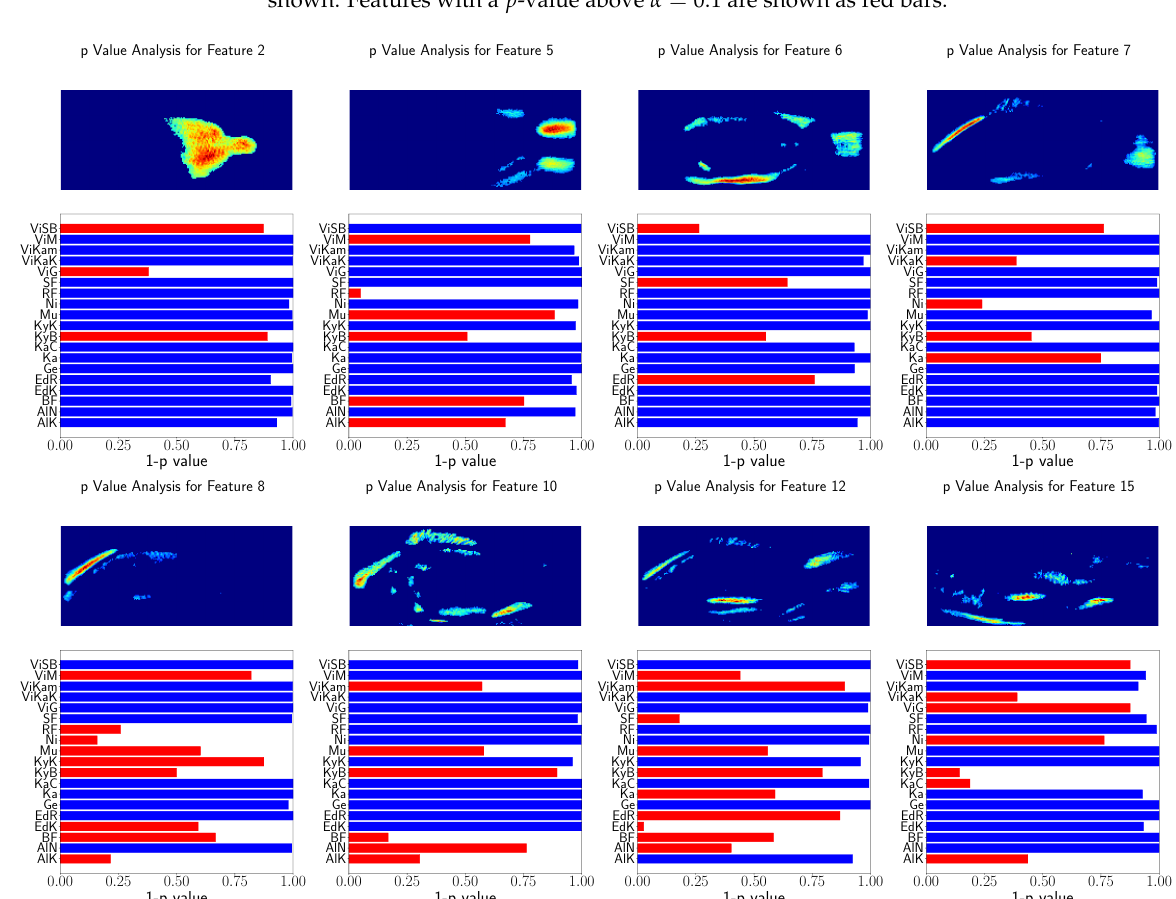
Figure 9. Result of Spearman’s rank correlation test for the relation between the manually selected GP-LVM features and population locations in Uganda. The features with highest ARD values are shown. Features with a p -value above α = 0.1 are shown as red